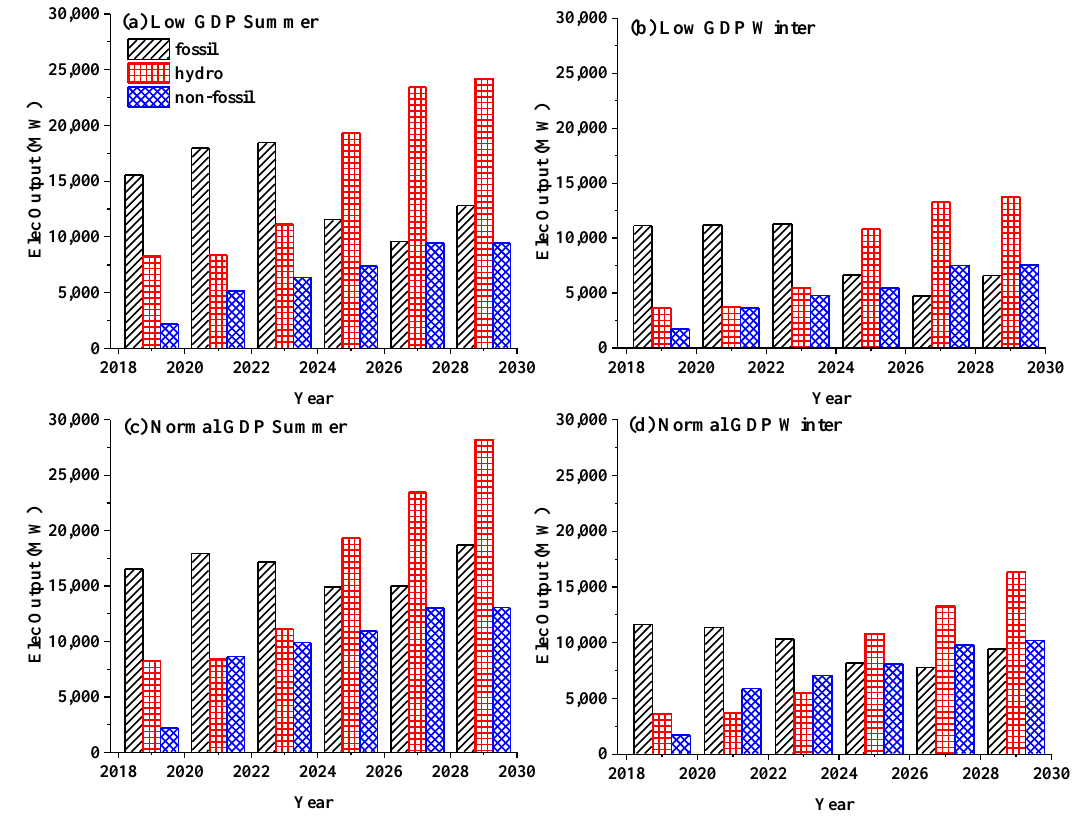
Figure 10. Optimal energy mix for fuel balancing at the 4–40% mitigation target.